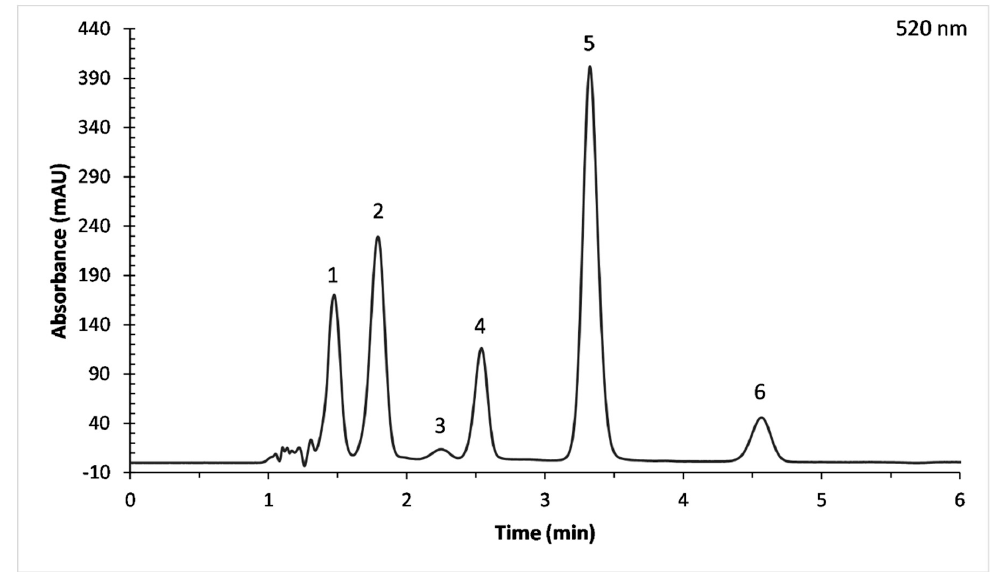
Figure 2. High performance liquid chromatography (HPLC) chromatogram at 520 nm of PJ (Ermioni variety) ACNs. 1: Dp-3,5-diglucoside, 2: Cy-3,5-diglucoside, 3: Pg-3,5-diglucoside, 4: Dp-3-glucoside,